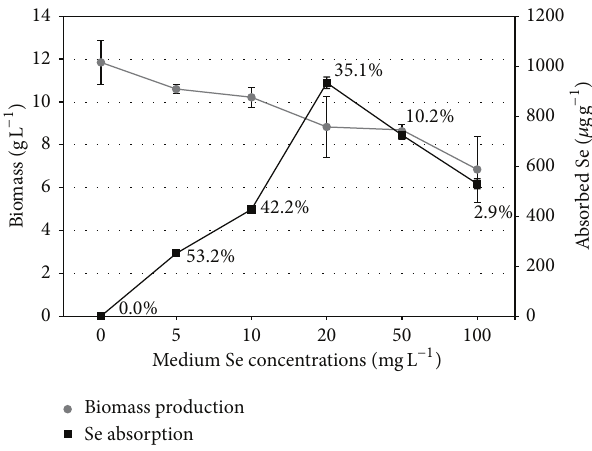
Figure 1: Biomass production and Se absorption by Pleurotus ostreatus depending on Se amount in the medium. (Data represent mean values of three samples. Variations are given as standard